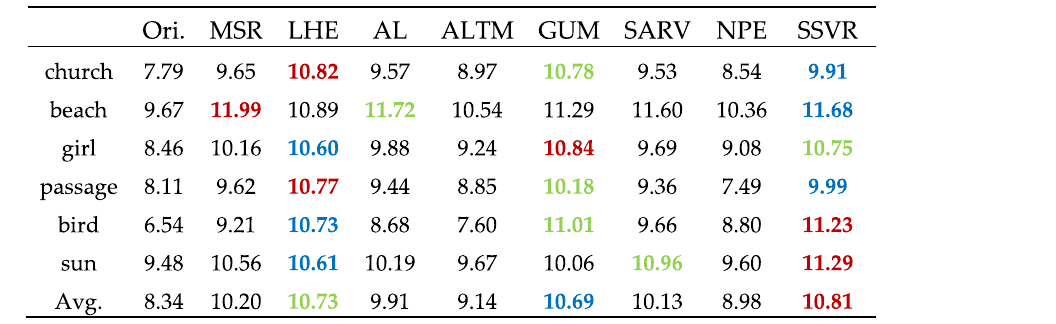
Red color data represents the highest value, green color data represents the second highest value, blue color data represents the third highest value